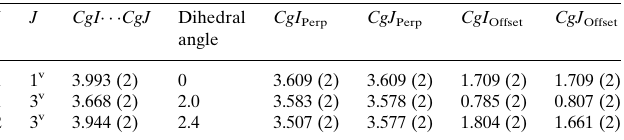
Table 2 (cid:2) – (cid:2) Interactions (A˚ , (cid:3)